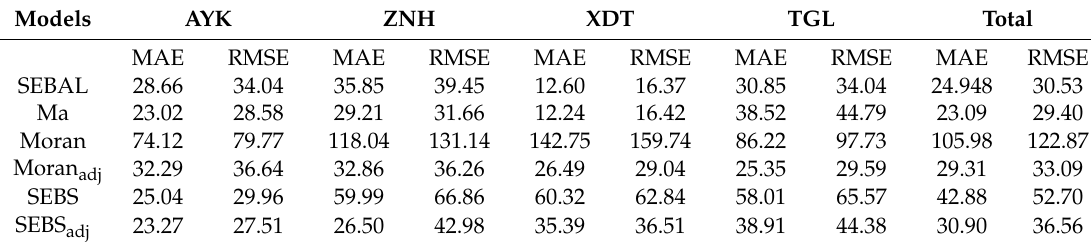
Table 5. MAE and RMSE for G 0 parameterization schemes at 4 stations (W/m 2